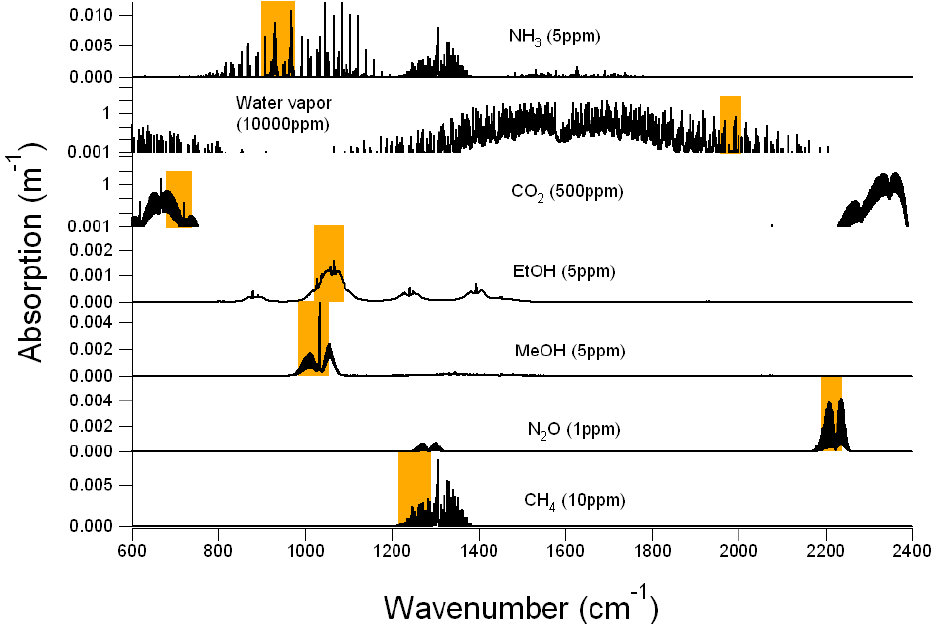
Figure 1. Example of infrared (IR) absorption spectra of CH and H O (black solid lines). Locations and bandpass of filters corresponding to each NH 3 2 gas are shown in orange rectangles on each plot. In Example #1, CH N O and H O are target gases and NH 2 2 O, NH and H O are target gases and CH EtOH, N 2 3 2